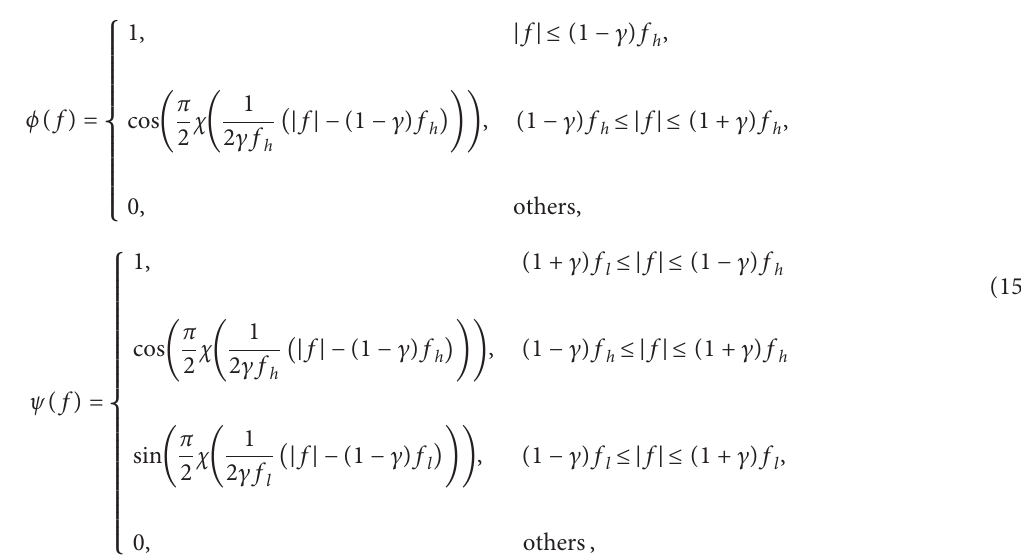
( t ) . (b) The Fourier spectrum of simulation r